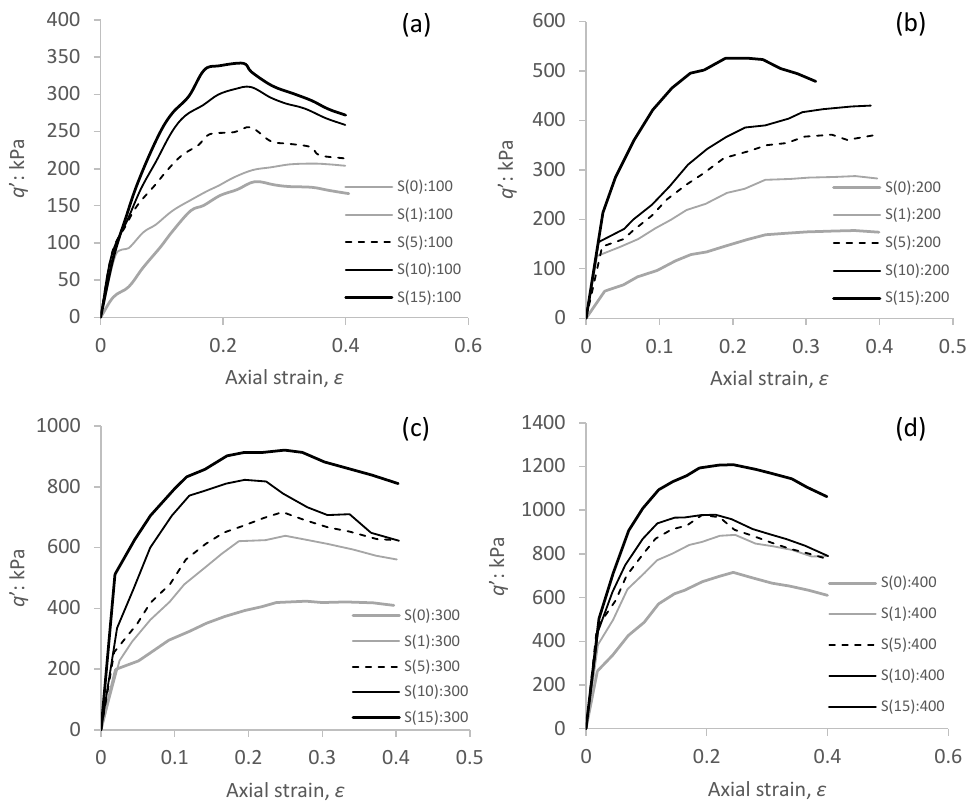
Figure 7. Stress-strain traces for undrained triaxial compression of base and NS-treated sands Figure 7. Stress–strain traces for undrained triaxial compression of base and NS-treated sands isotropically consolidated for p (cid:48) values of: ( a ) 100 kPa; ( b ) 200 kPa; ( c ) 300 kPa; ( d ) 400 c isotropically consolidated for (cid:1868)′ (cid:2913) values of: (a) 100 kPa ; (b) 200 kPa ; (c) 300 kPa ; (d) 400 kPa .